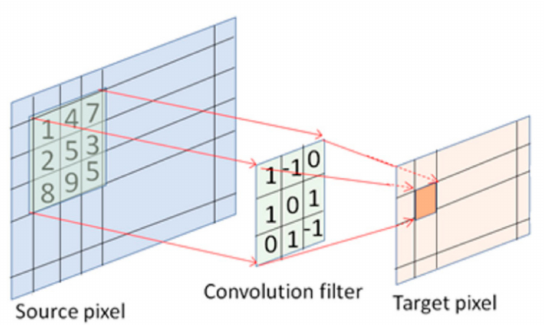
Figure 3. Depiction of the convolution layer with a filter in convolutional neural network